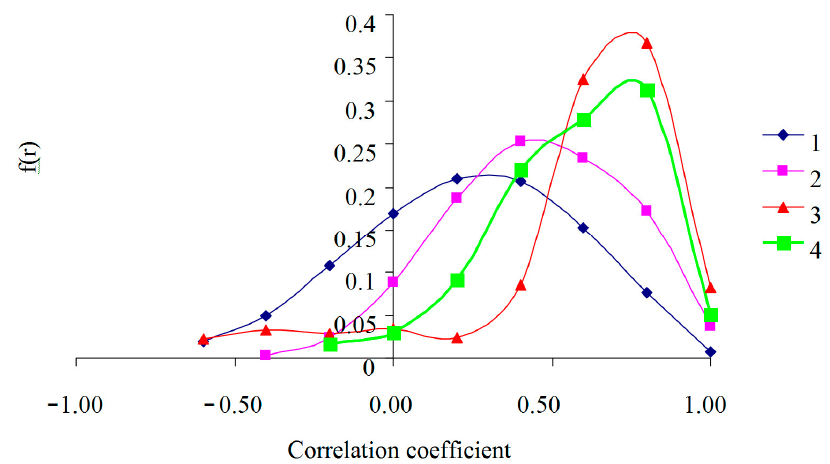
Figure 8. The function of distribution f ( r ) of correlation coefficients of the TRW FD time series for different sample plots. Curve 1–sample plot No. 4; curve 2–sample plot No. 2; curve 3–sample plot No. 3; curve 4–sample plot No. 1.